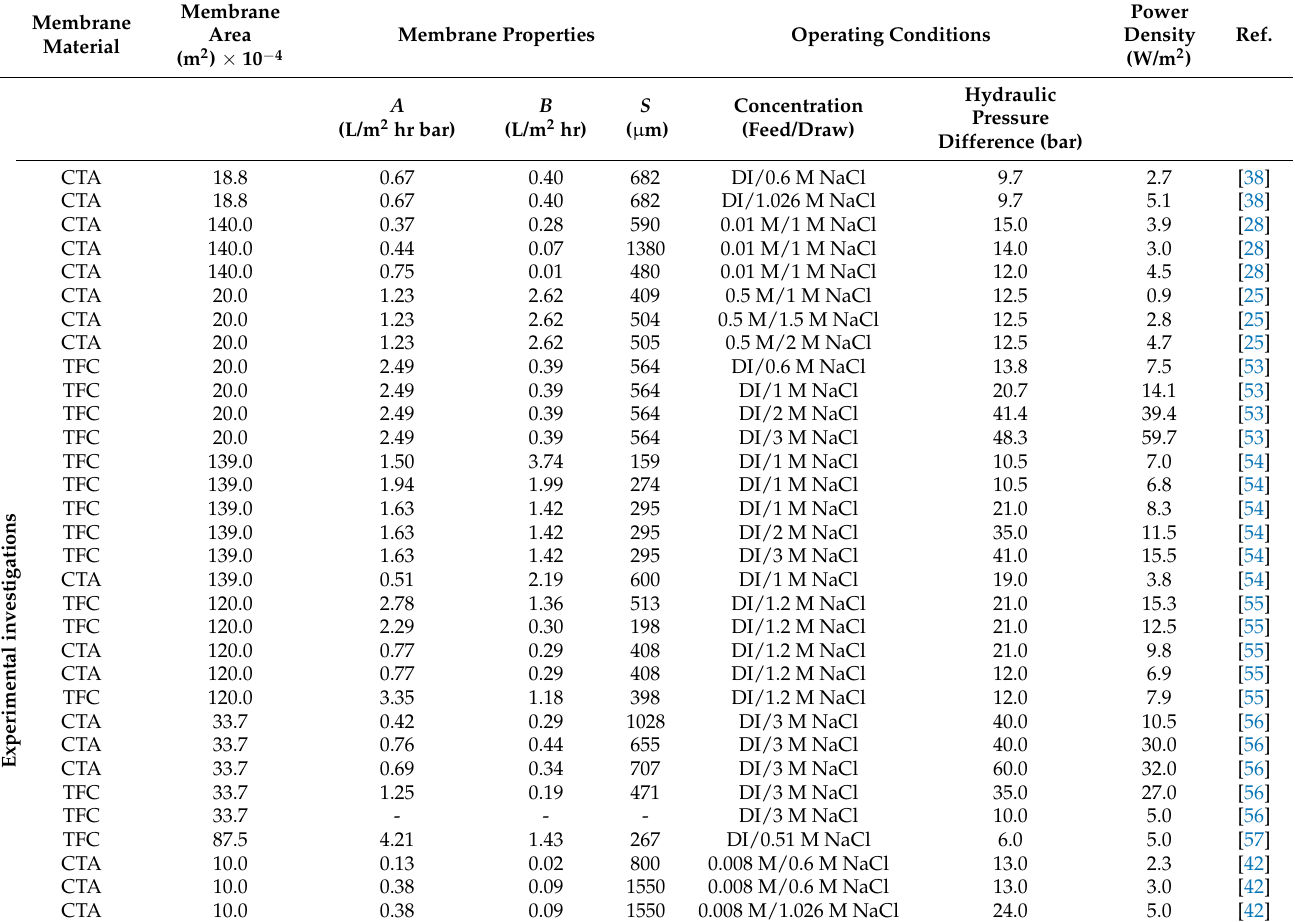
Table 2. Performance and key properties for commercially available membranes in a single flat sheet membrane module from both experimental and numerical